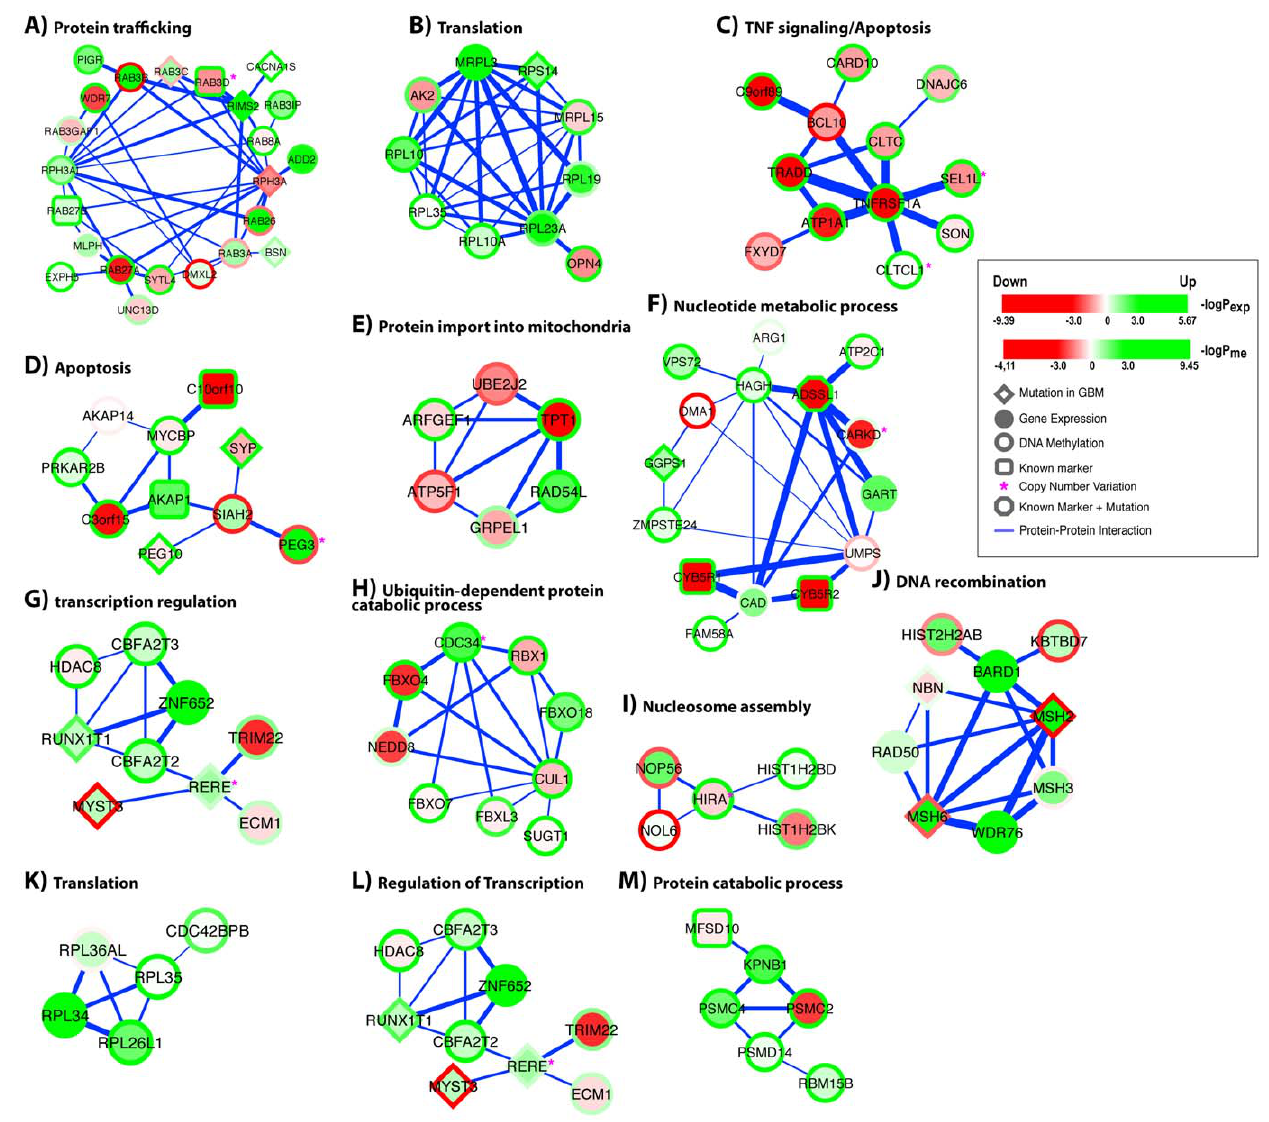
Figure 5. The set of multi-analyte prognostic modules identified by the MAPIT algorithm. Ten eModules ( A–J ) and three mModules ( K–M ) are shown. Node colour represents gene expression change of LTS patients compared to STS patients. Red, down-regulation; Green, up-regulation. Shade is proportional to the 2 log (p-value) of the change. Node border colour represents DNA methylation change of LTS patients compared to STS patients. Red, hypomethylation; Green, hypermethylation. Shade is proportional to the 2 log (p-value) of the change. Diamond nodes, genes reported to bear somatic mutations in GBM patients. Rectangular nodes, genes identified as GBM prognostic markers in either [4] or [6]. Hexagonal nodes, genes both reported to bear somatic mutations and identified as prognostic markers in either [4] or [6]. Purple star: genes located in CNV regions identified in GBM patients [37]. Edge, protein-protein interaction. Edge width is proportional to the combined significance of expression changes of the two involved nodes (see Methods for